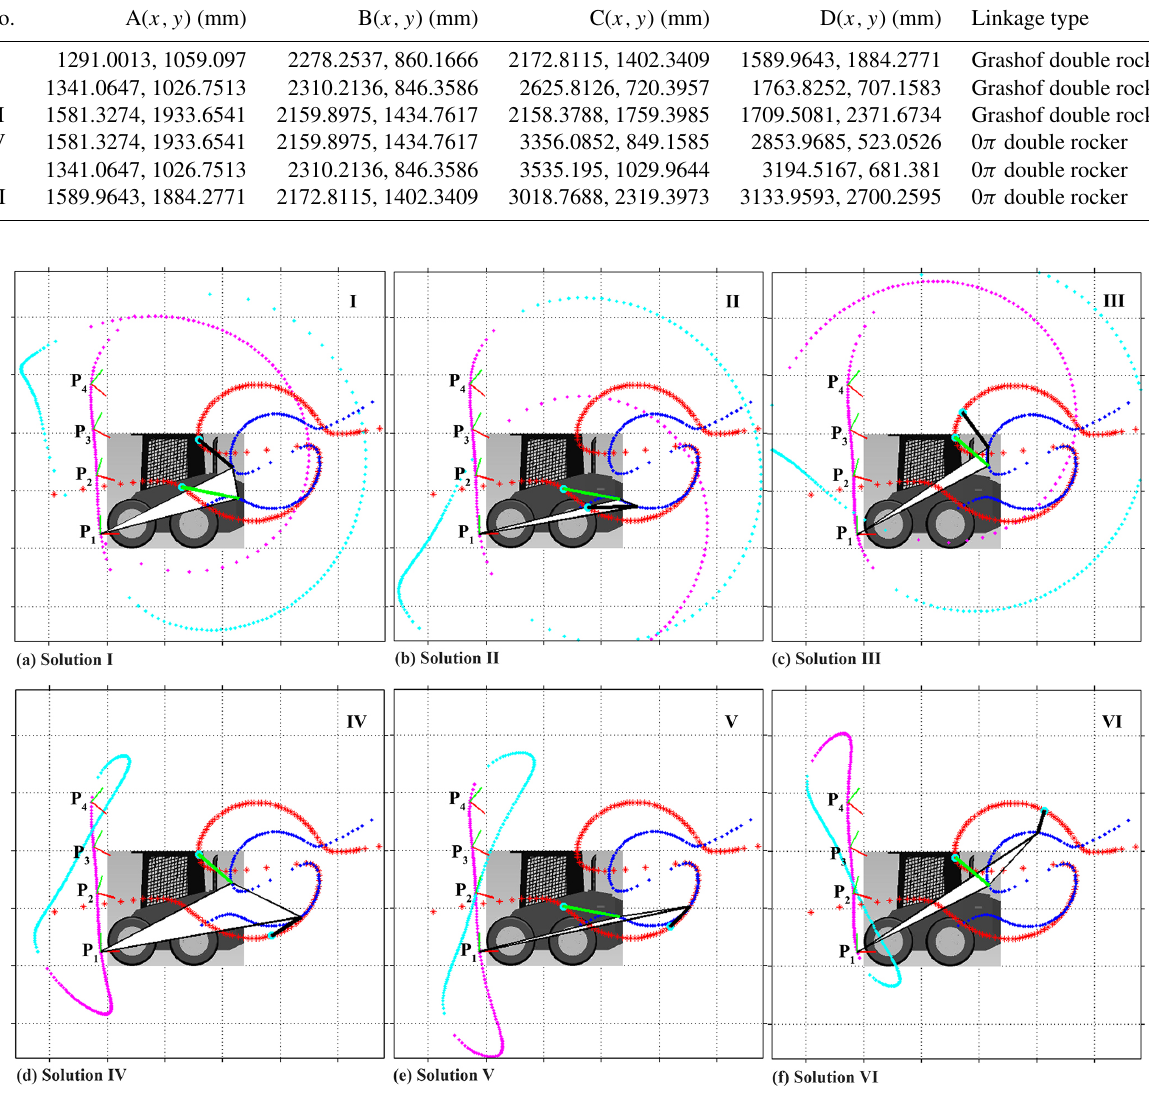
Figure 13. Solutions